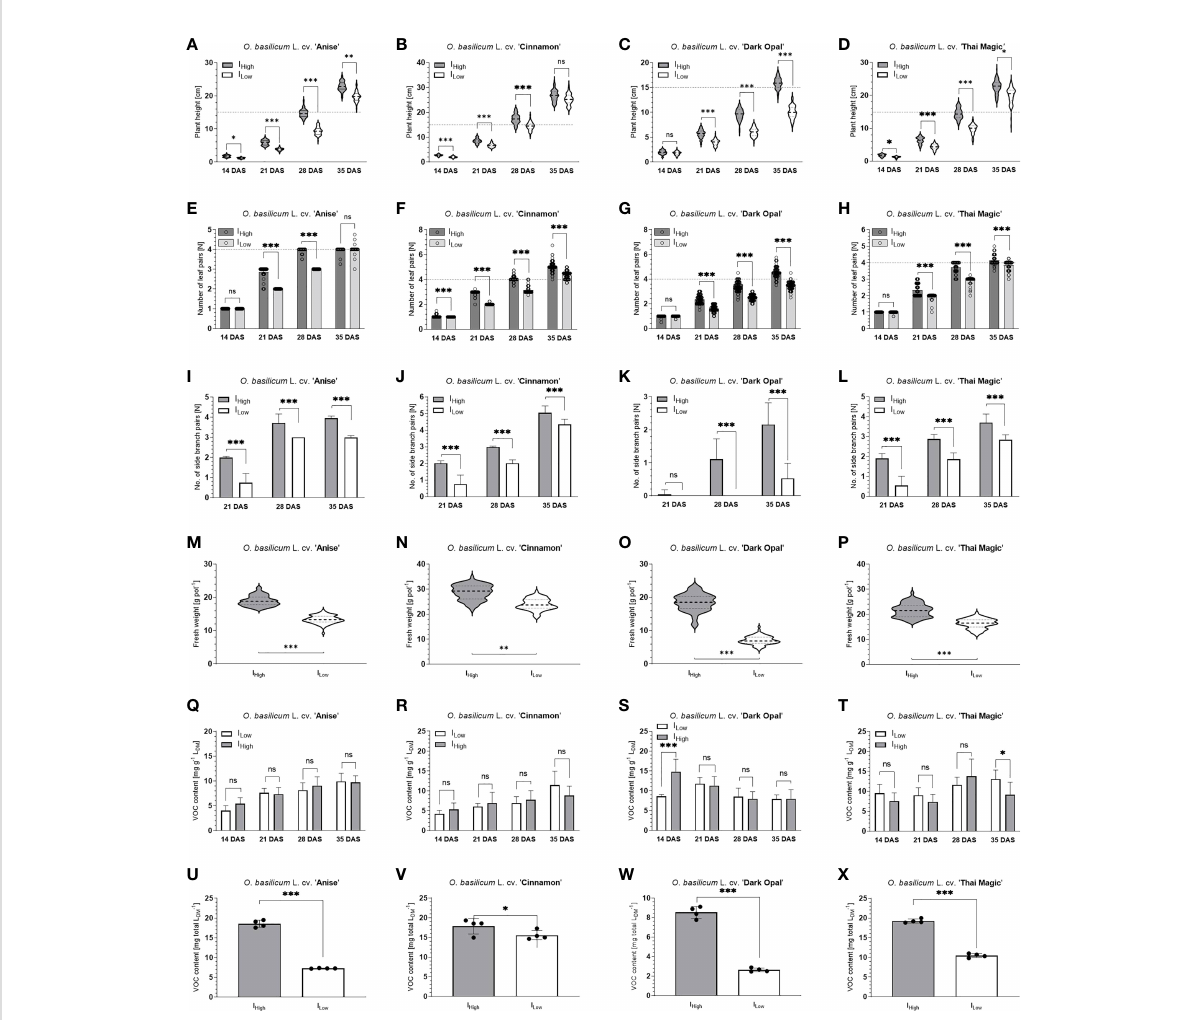
FIGURE 5 Characteristics of four Ocimum basilicum L. cultivars under two different broad-bandwidth LED light intensities over time. A-D : Plant height development of basil cultivar ‘ Anise ’ (A) , ‘ Cinnamon ’ (B) , ‘ Dark Opal ’ (C) and ‘ Thai Magic ’ (D) over time (dashed and dotted lines within violin plots represent medians and quartiles (25th and 75th percentile) of the data sets, respectively; dashed lines horizontally across the graph represent marketability at height ≥ 15cm); E-H : Leaf pair development of basil cultivar ‘ Anise ’ (E) , ‘ Cinnamon ’ (F) , ‘ Dark Opal ’ (G) and ‘ Thai Magic ’ (H) over time (dashed lines represent marketability at a number of leaf pairs ≥ 4); I-L : Branch pair development of basil cultivar ‘ Anise ’ (I) , ‘ Cinnamon ’ (J) , ‘ Dark Opal ’ (K) and ‘ Thai Magic ’ (L) over time; M-P : Fresh weight per pot of basil cultivar ‘ Anise ’ (M) , ‘ Cinnamon ’ (N) , ‘ Dark Opal ’ (O) and ‘ Thai Magic ’ (P) 35 days after sowing (at harvest; dashed and dotted lines within violin plots represent medians and quartiles (25th and 75th percentile) of the data sets, respectively); Q-T : Volatile organic compound content per gram of leaf dry matter of basil cultivar ‘ Anise ’ (Q) , ‘ Cinnamon ’ (R) , ‘ Dark Opal ’ (S) and ‘ Thai Magic ’ (T) over time; U-X : Total volatile organic compound content per total leaf dry matter of basil cultivar ‘ Anise ’ (U) , ‘ Cinnamon ’ (V) , ‘ Dark Opal ’ (W) and ‘ Thai Magic ’ (X) 35 days after sowing (at harvest). I High , High light intensity treatment; I Low , Low light intensity treatment; DAS, days after sowing; dashed horizontal lines represent marketability (de fi ned as /plant height ≥ 15cm and/ or number of leaf pairs ≥ 4); LDM, leaf dry matter; VOC, volatile organic compound; signi fi cance levels: ns = not signi fi cant, * ≤ 0.05, ** ≤ 0.02, *** ≤ 0.01; please note the differently scaled Y-axes between